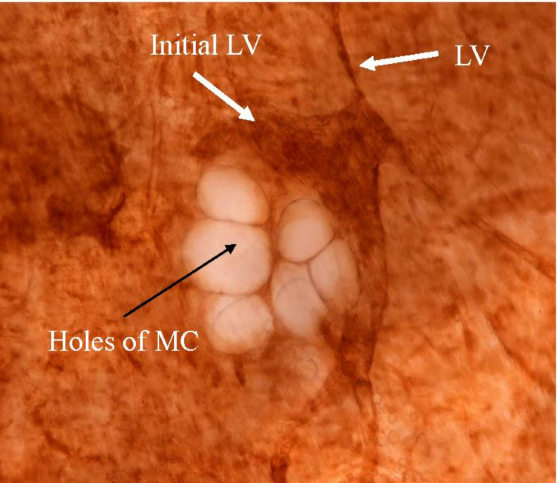
Figure 10. Holes in the diaphragmatic macula cribriformis (MC) connect with the initial lymphatic vessels (5 (cid:48) -Nase enzyme staining). Initial LV: initial lymphatic vessel. LV: lymphatic vessel connects with the initial lymphatic